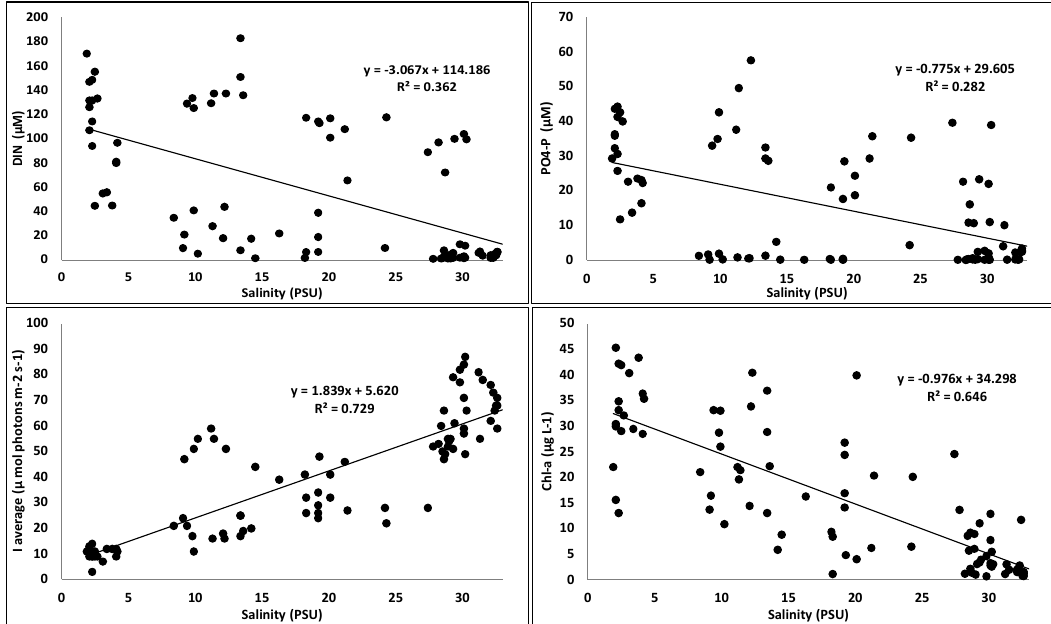
Figure 3. Results of regression analyses for salinity versus dissolved inorganic nitrogen (DIN), phosphates, light, and chlorophyll-a (Chl-a) in Jakarta Bay.